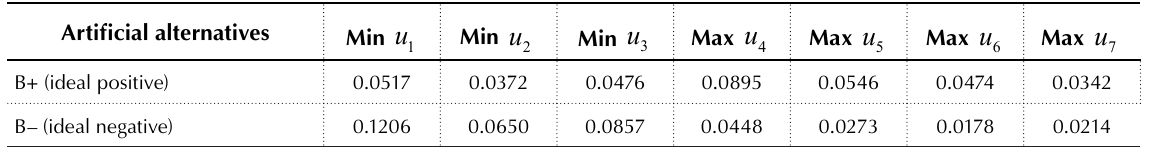
capital development according to predefined criteria (the criteria values are obtained by ex- Edgeworth – Pareto set.